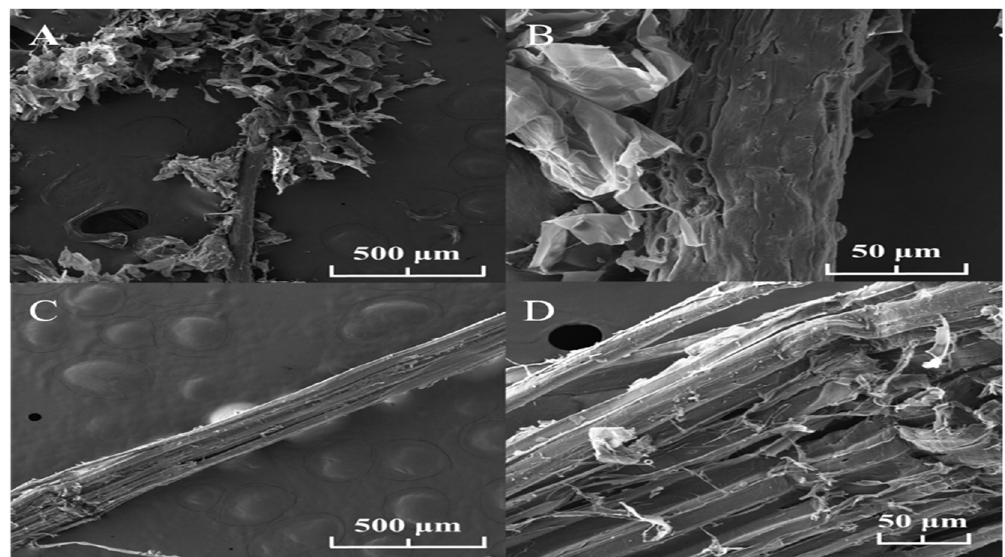
Figure 1. Scanning electron microscopy (SEM) analysis of the natural coconut and sisal fibers to determine the fiber morphology: ( A ) coconut (scale bar, 500 um), ( B ) coconut (scale bar 50 um). The coconut fibers have an irregular shape, emphasizing internal spaces in the structure. ( C ) Sisal (scale bar, 500 um), ( D ) sisal (scale bar, 50 um), sisal fibers have a straighter, more compact structure. The fibers differ in their organization and surface; therefore, they will have different properties .